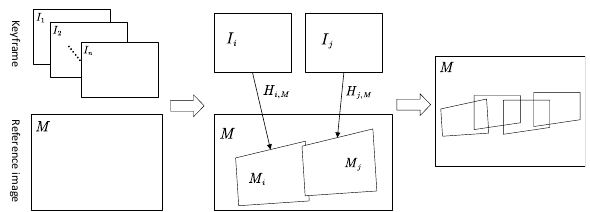
Figure 2. Registration from keyframe to reference image